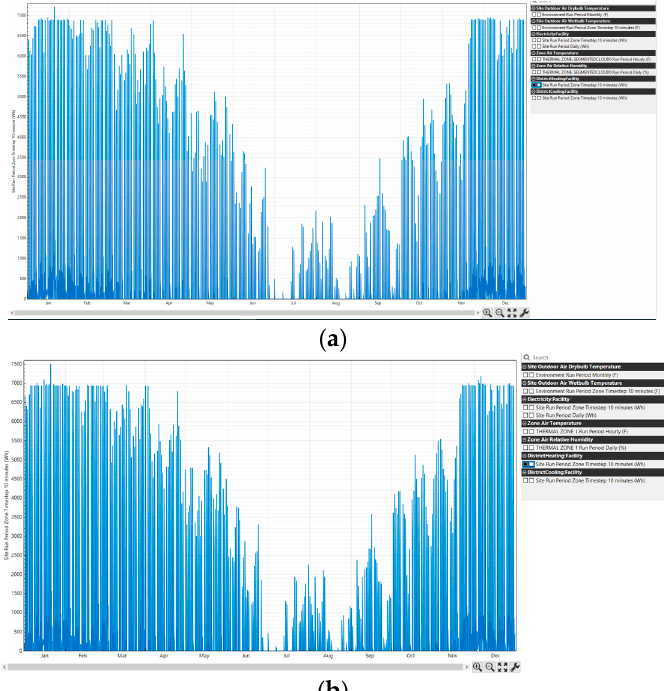
Figure 23. Comparison between heating consumption along a year for scenario 2: ( a ) Estimated model; ( b ) Manually generated model.